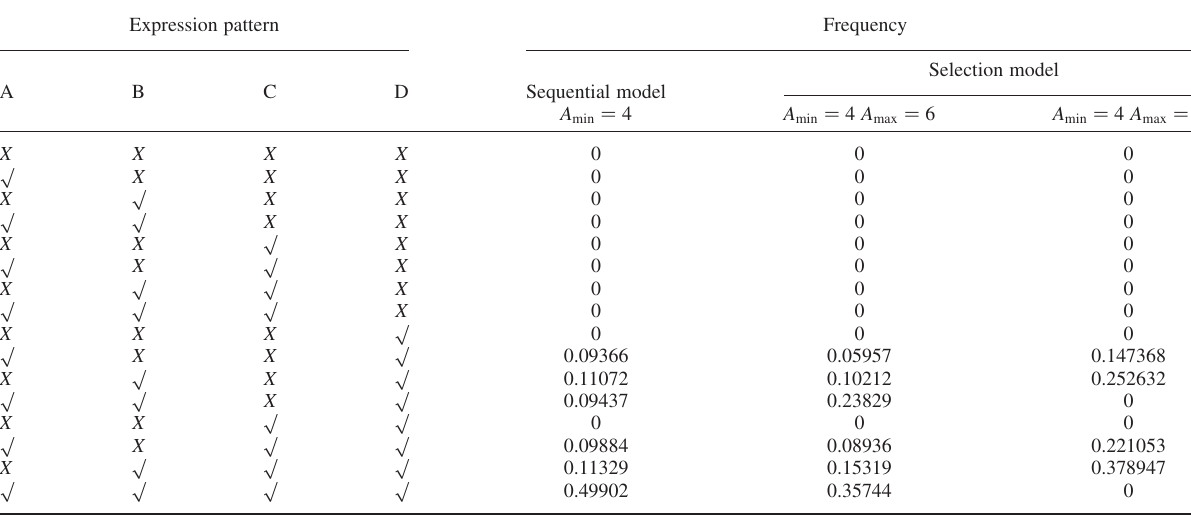
TABLE III The post-selection repertoires that had been shaped according to each model Expression